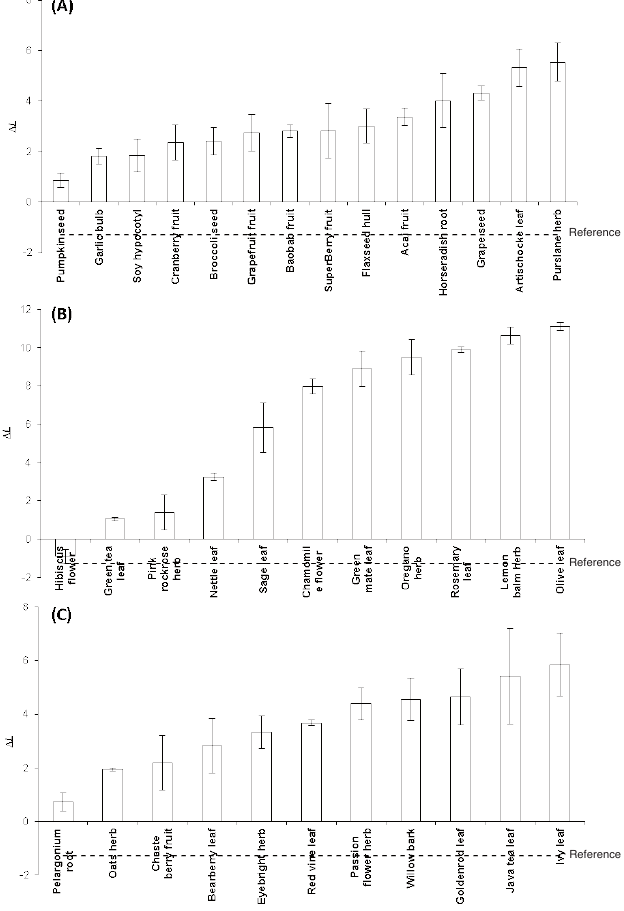
Fig. 1: Browning of fresh-cut apples treated with 1 % plant extract solutions 4 h after treatment compared to the sodium bisulfite solution (reference). Apple samples were treated with extracts from (A) fruits, vegetables, and oil fruits/seeds, (B) herbs and tea plants, and (C) medicinal plants. Vertical bars represent the standard deviation of the mean (n =